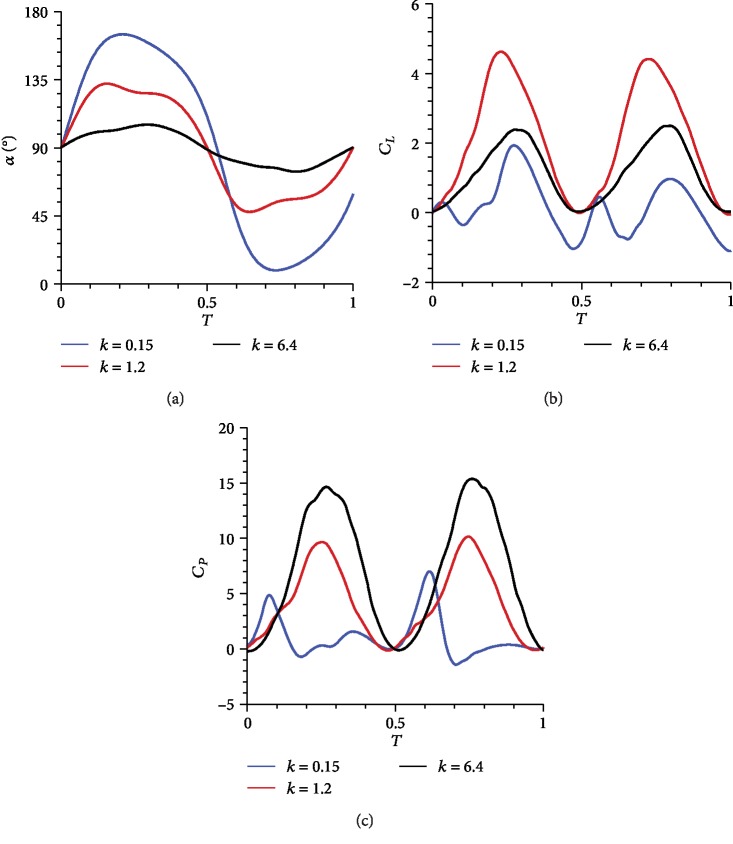
Instantaneous (a) α, (b) CL, and (c) CP under different k.